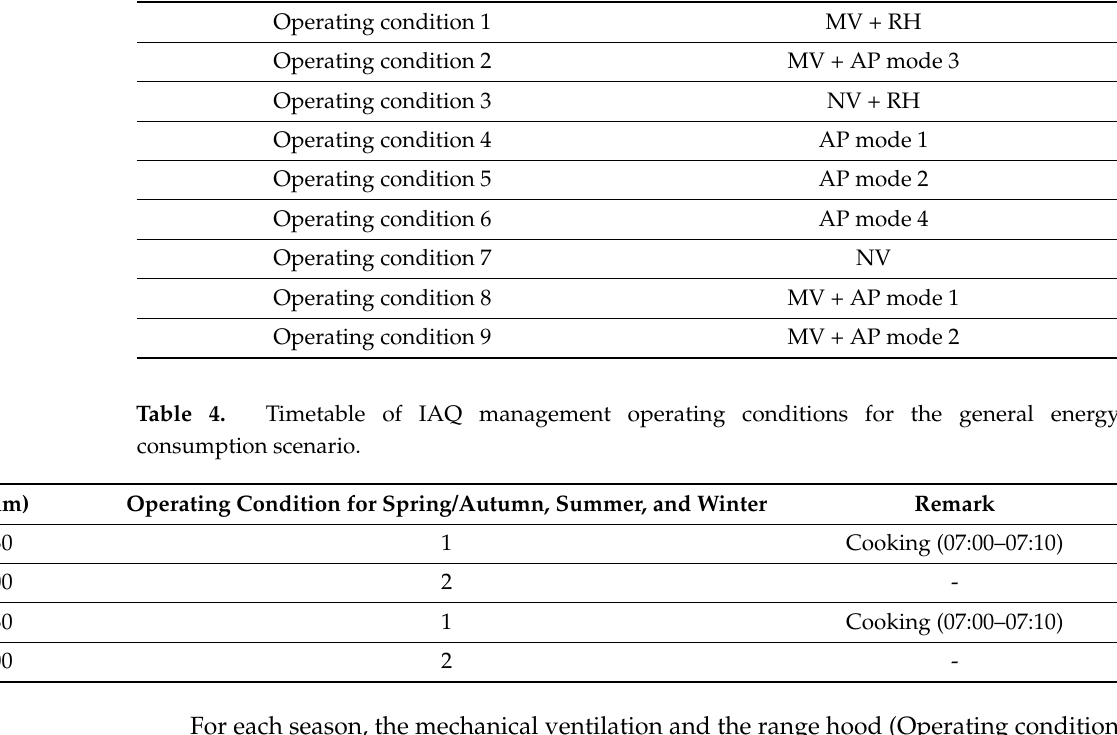
Table 3. Operating conditions of IAQ management methods (NV: natural ventilation, MV: mechanical ventilation, RH: range hood, and AP: air purifier).